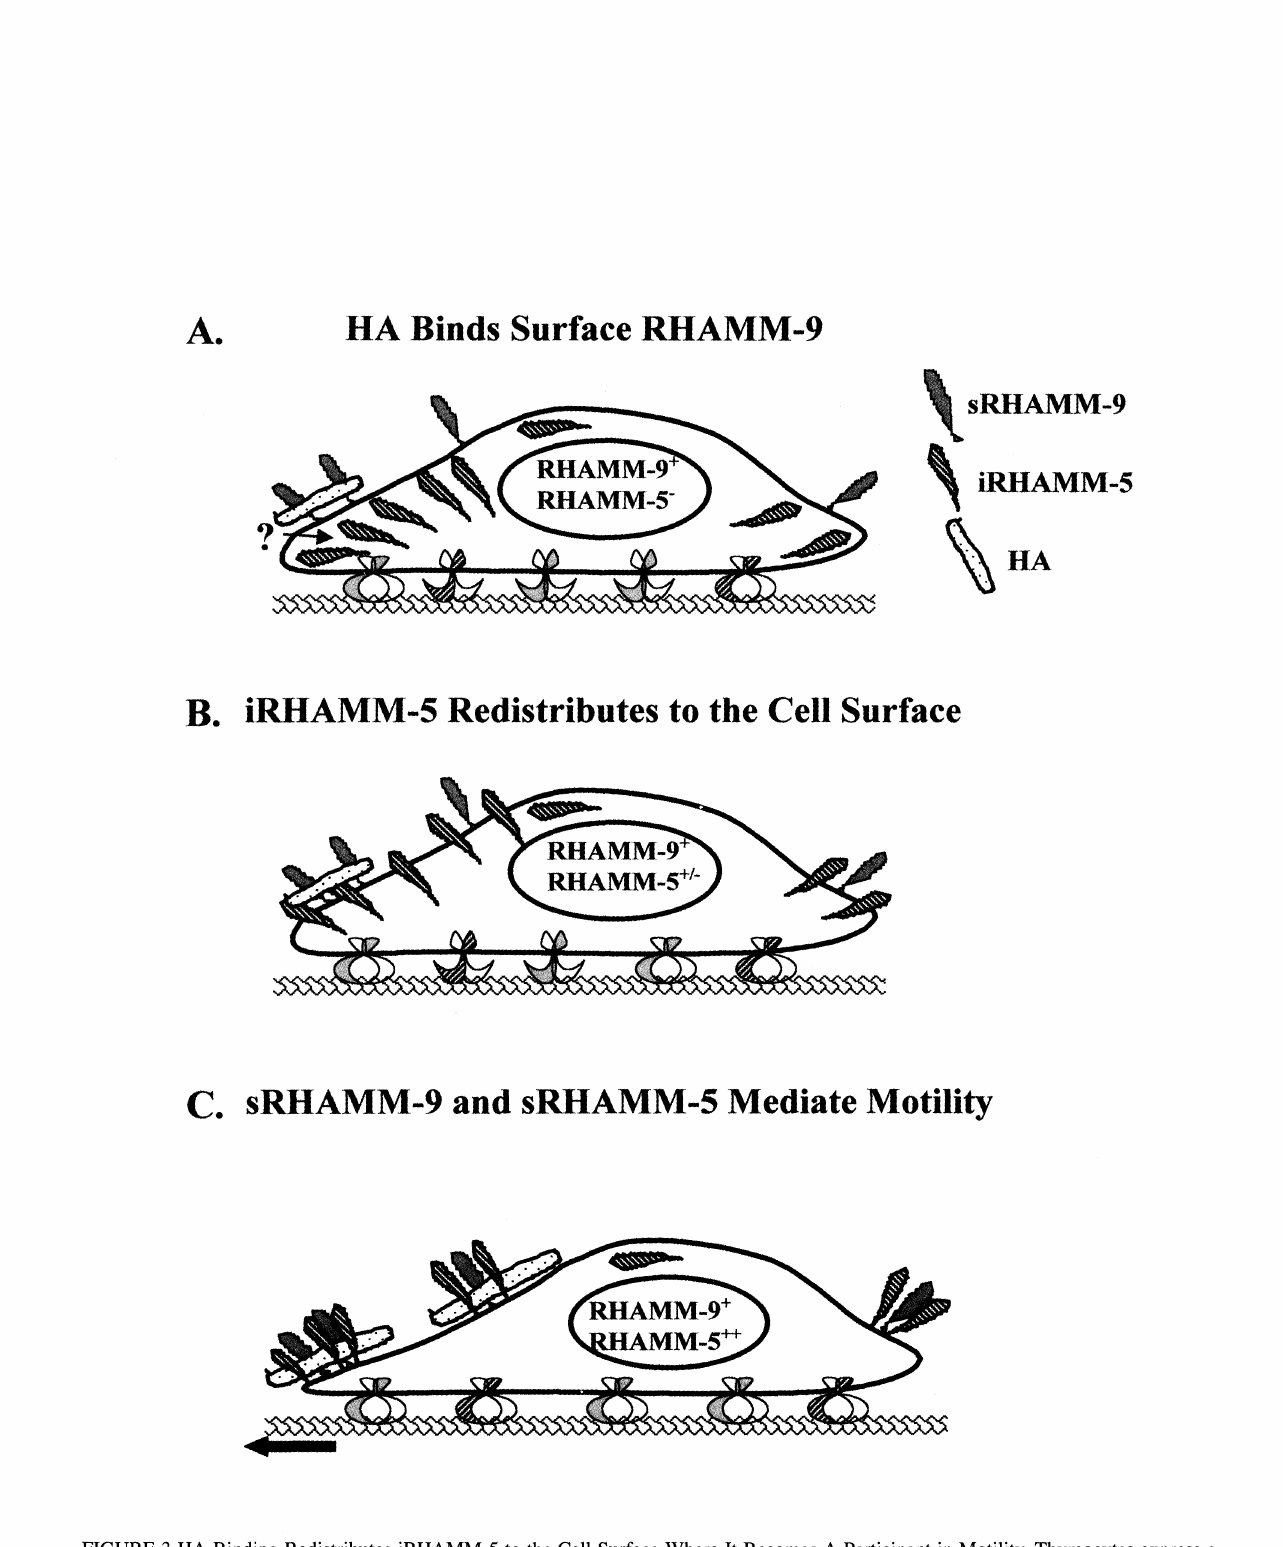
FIGURE 3 HA Binding Redistributes iRHAMM-5 to the Cell Surface Where It Becomes A Participant in Motility. Thymocytes express a low density of sRHAMM-9 and a higher density of iRHAMM-5. Prior to HA binding to sRHAMM-9, integrins may bind Fn with high avid- ity and maintain sessile behavior for thymocytes (A). HA binding to sRHAMM-9 initiates signals that result in a redistribution of iRHAMM-5 to the cell surface and conversion of integrins to low avidity binding conformations (B). At the cell surface, sRHAMM-5 asso- ciates with sRHAMM-9 to form HA binding complexes that mediate motility. Low avidity binding conformations of integrins mediate weak adhesive contacts with Fn that provide traction for the locomoting thymocytes